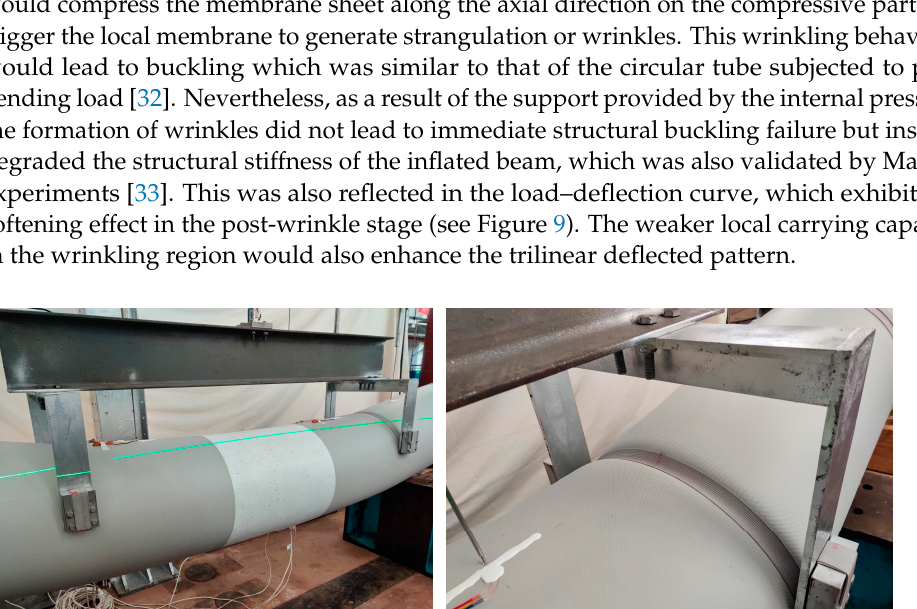
Figure 11. The local deformed pattern of the inflated sample close to ultimate load: ( a ) bending region; ( b ) loading